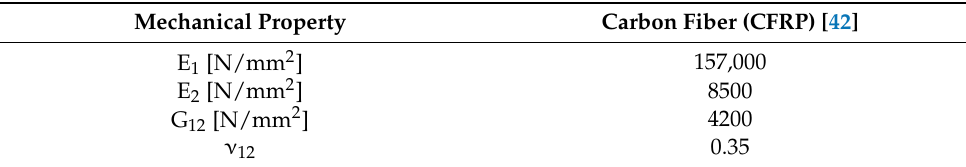
Table 1. Material properties of CFRP